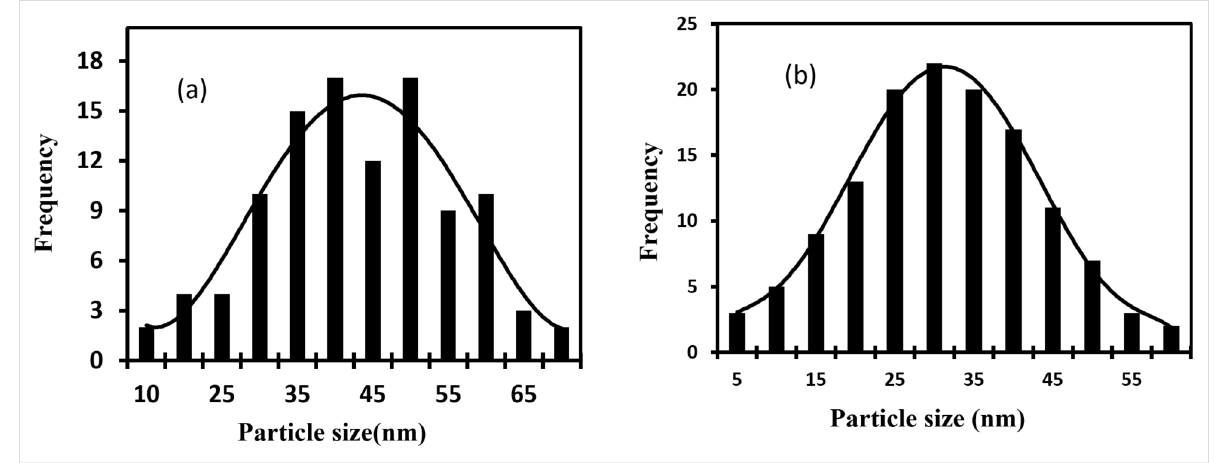
Figure 9: Particle size distribution of Ag 2 S NPs synthesized (a) without and (b) with CTAB.